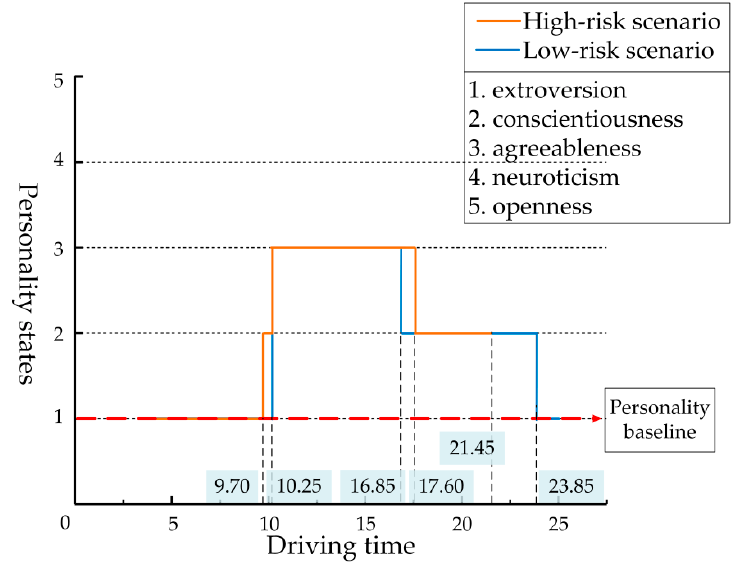
Figure 10. Changes of personality state in high- and low-risk scenarios based on driving distance.